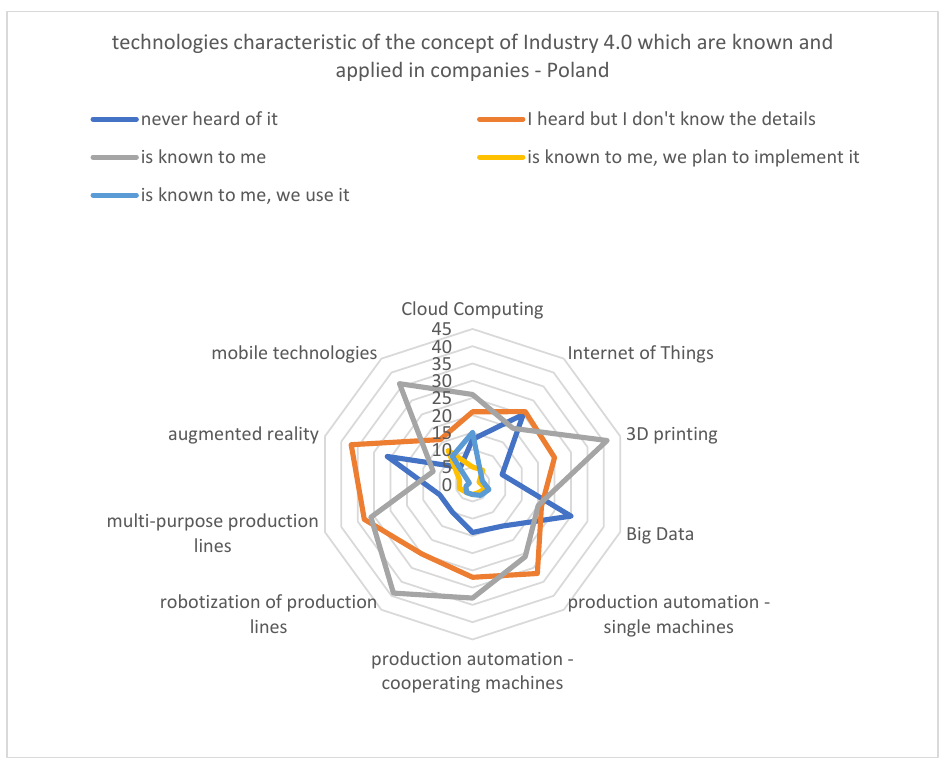
Figure 1. Technologies characteristic of the concept of Industry 4.0 which are known and applied in companies—Poland. Source: elaborated by the authors.